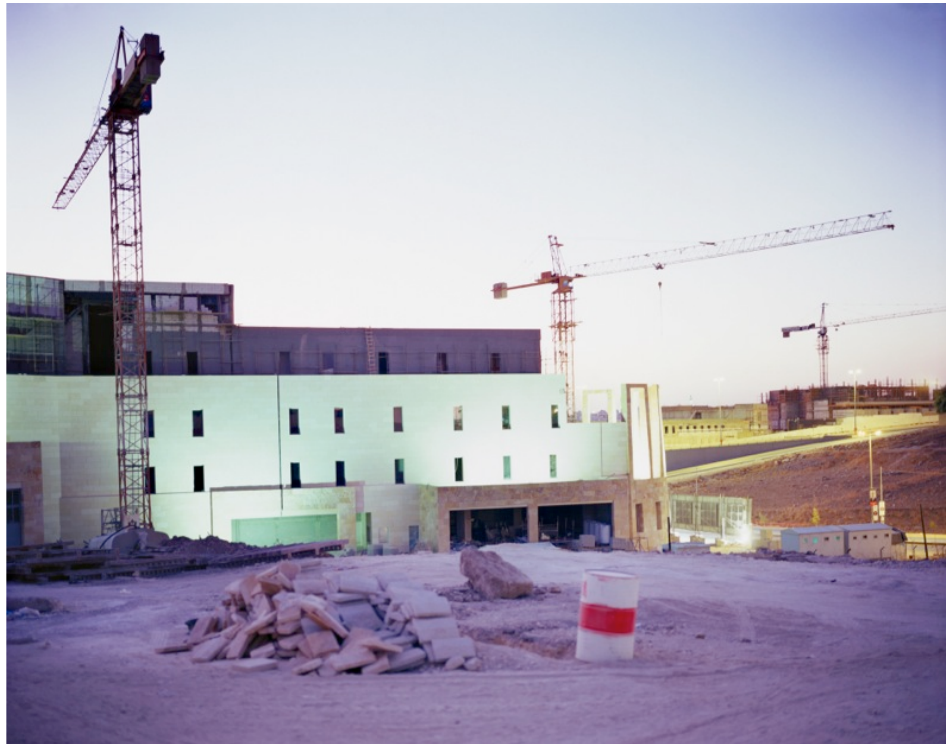
Regina Mamou, Untitled (Site #2) from the series Mapping Collected Memory , 2009–2010. Digital C-print. 40 x 50 in. (101.60 x 127